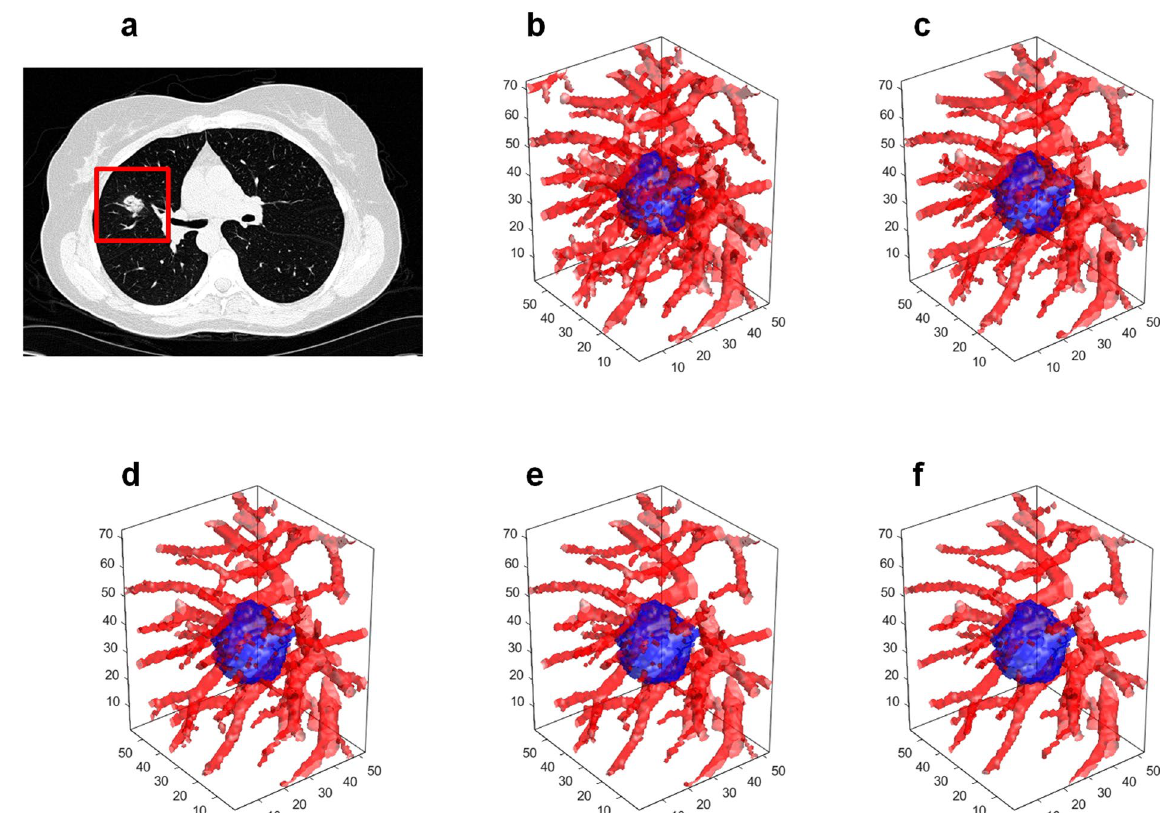
Figure 10. ( a ) A nodule and the region of interest. ( b – f ) Segmentations of the same nodule and its corresponding vasculature which were generated by assigning the following values respectively to the parameter S : − 150, − 100, − 50, 0 and